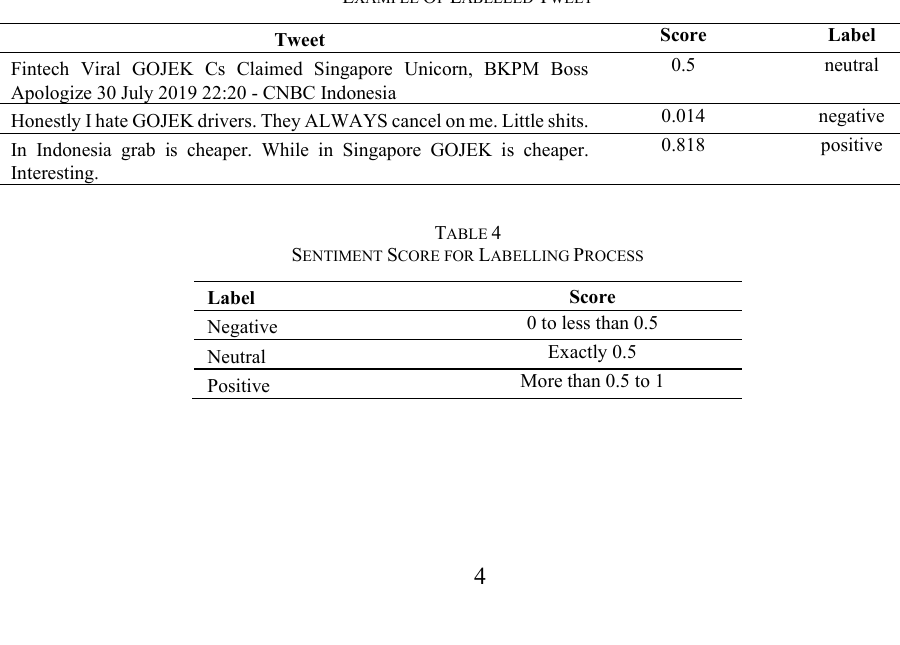
Table 3. The sentiment score of each label provided by Microsoft Text Analytics API is drawn in Table